Question: What type of chart is this?
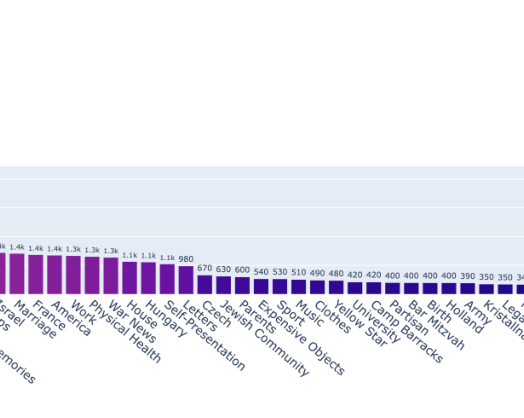
Answer: histogram